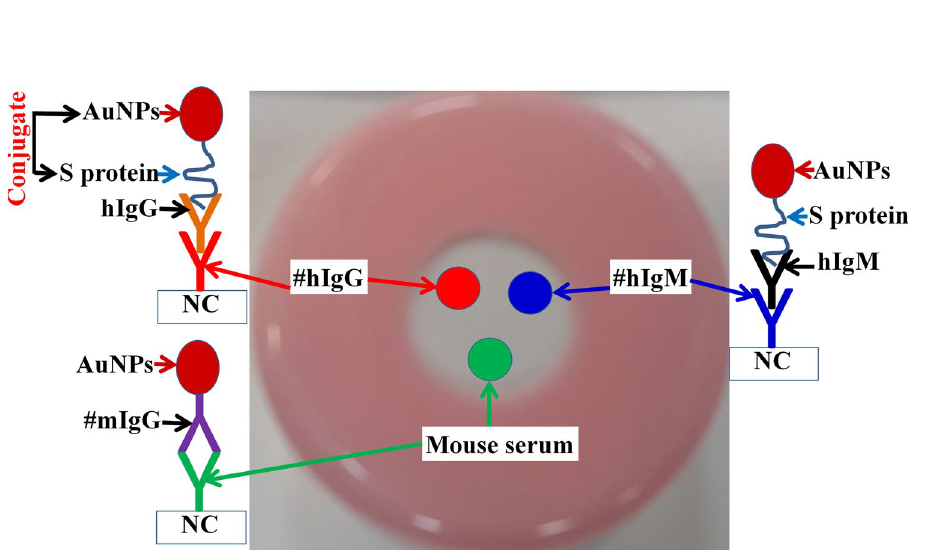
Figure 7. Principle structure and work of the TLTD. Where NC: nitrocellulose membrane; #hIgG: anti-human IgG Abs; hIgG: human IgG; #hIgM: anti-human IgM Abs; hIgM: human IgM; #rIgG: anti-rabbit IgG Abs. AuNPs: Gold